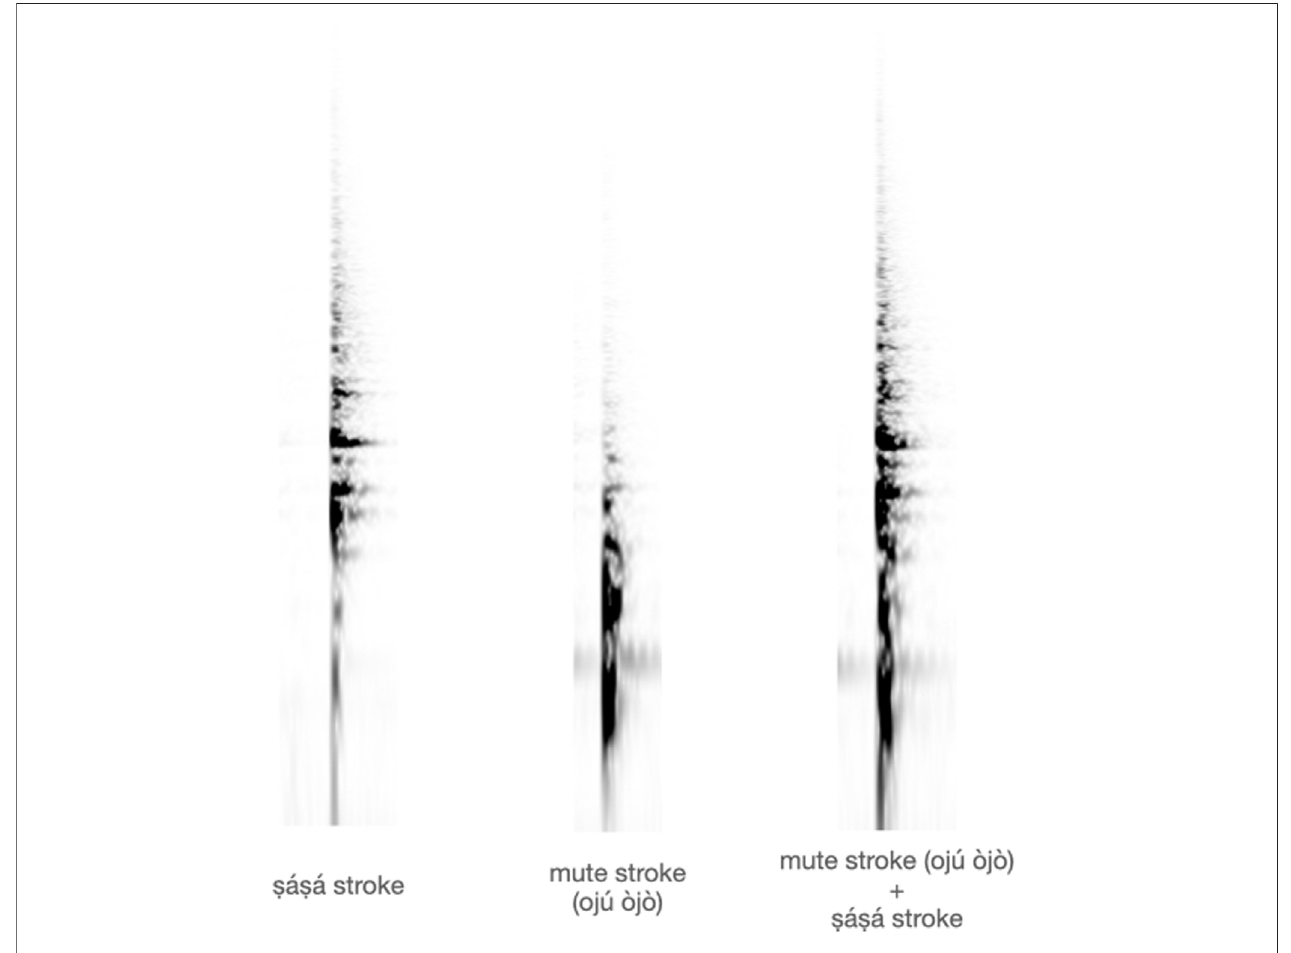
FIGURE 8 | Spectra of ìyáàlù bàtá